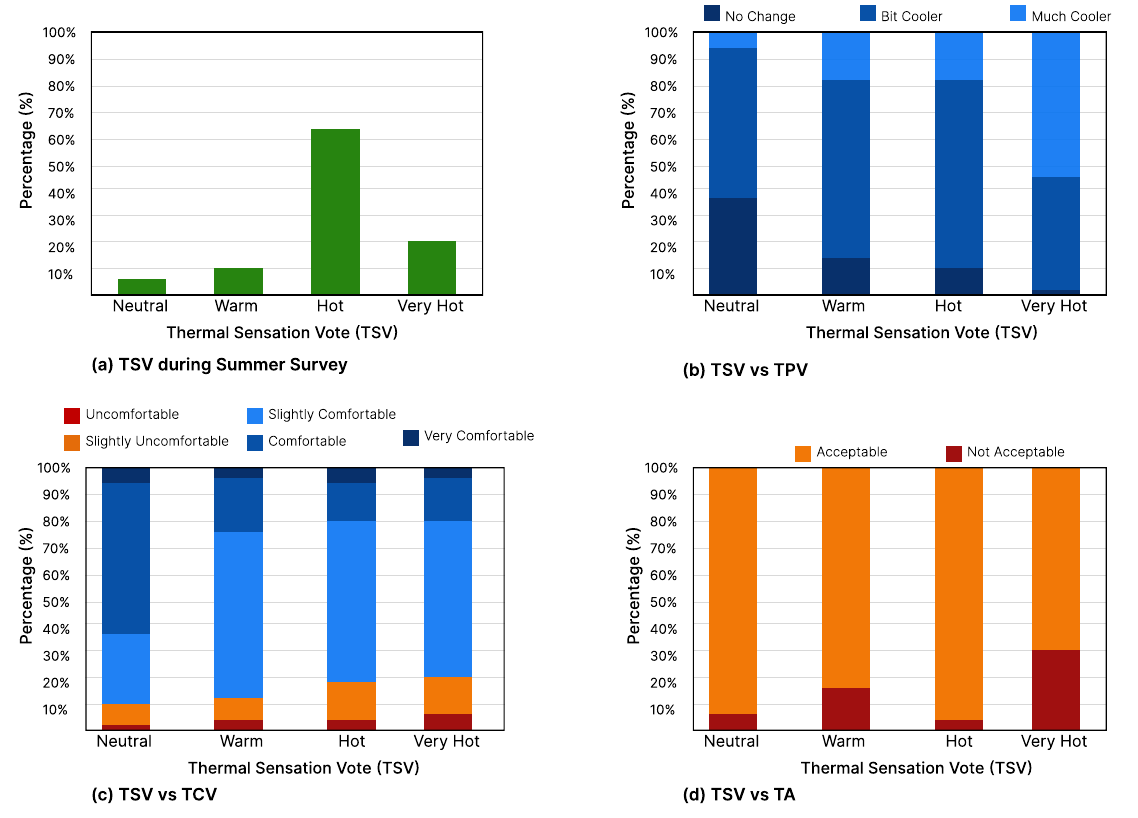
Figure 3. Thermal Sensation Vote vs TPV, TCV and TA for Summer Surveys. To further examine the relationship between how the students felt (sensation) and their respective thermal preference, comfort and satisfaction, the TPV, TCV, TA and TSL for TSV = 0 “neutral” is presented in Figure 4a,b for winter and summer surveys, respectively. When TSV = 0, students have neutral sensations (neither cold nor hot), and it is observed that 60% of the students prefer no change (TPV = 0) in their indoor environment during the winter compared to 5% in the summer. A total of 93% students considered their classroom as comfortable (TCV = 2, 3) during winters in contrast to 63% during summer. Similarly, the number of students who were satisfied with their indoor environment while feeling neutral was higher during the winter (87%) than in the summer (62%).